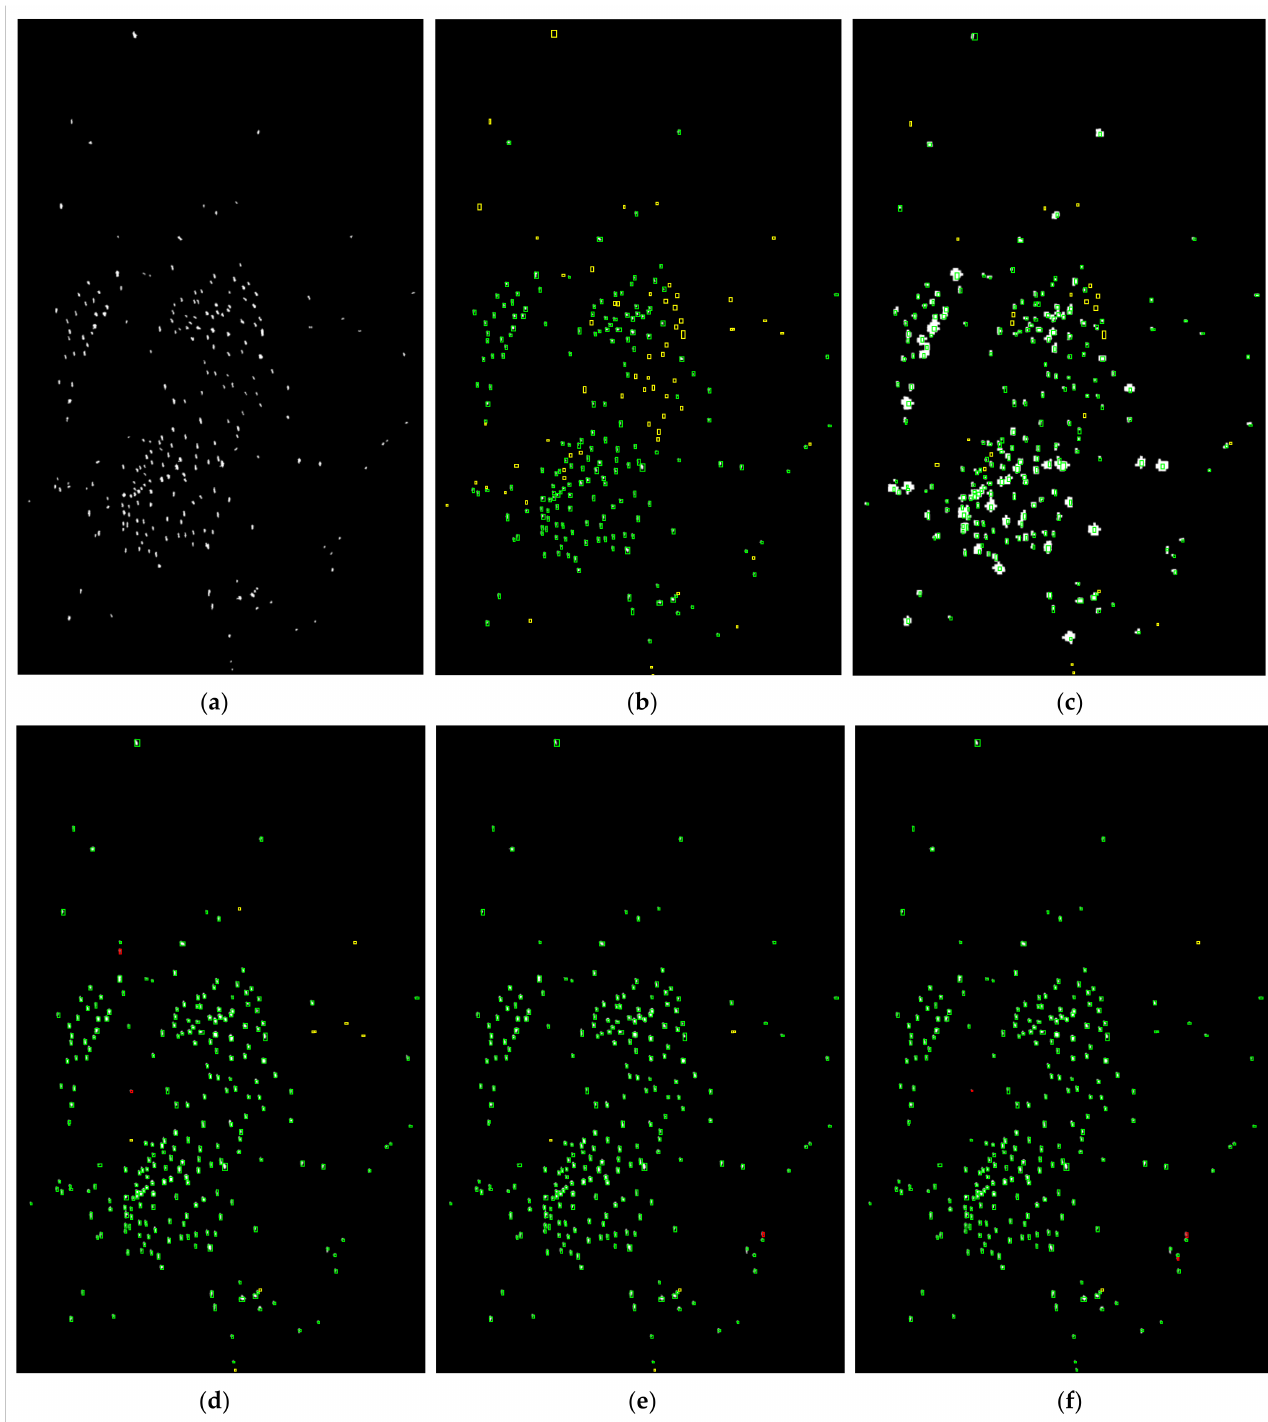
Figure 11. Detection results from GF-3 area II. ( a ) Ground-truth image. ( b ) SO-CFAR. ( c ) SP. ( d ) T3 + SVM. ( e ) PCP + SVM. ( f ) Proposed method. (Green: correct detection, yellow: missed detection, red: false